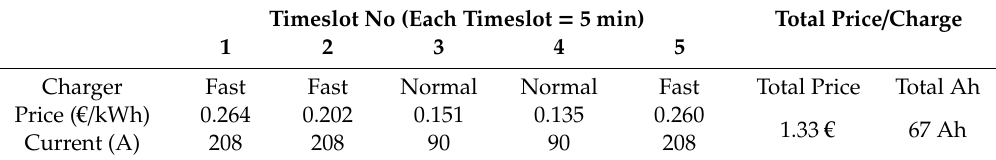
Table 2. The proposed indicative charging